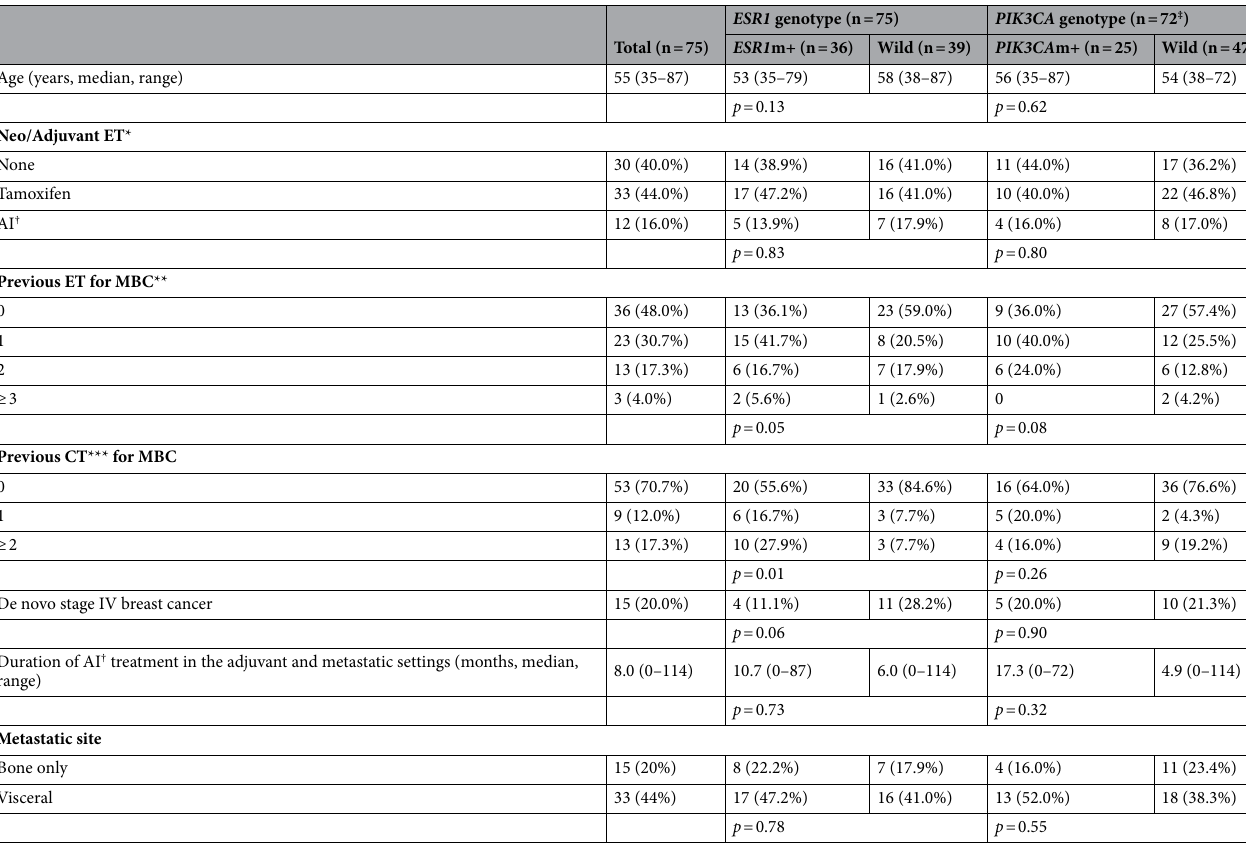
Table 1. Patient characteristics. *Endocrine therapy, **metastatic breast cancer, ***chemotherapy, † aromatase inhibitor, ‡ missing =